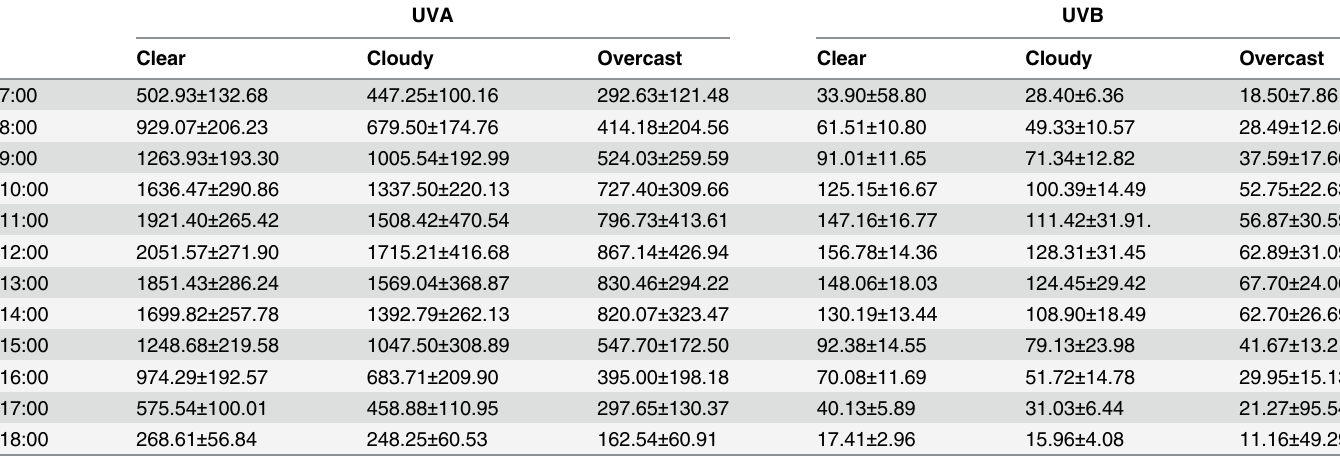
Table 1. Ultraviolet light intensity at different times in three types of weather ( μ W/cm 2